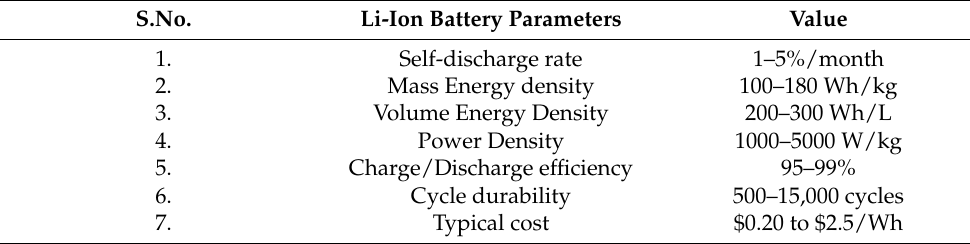
Table 1. Lithium-ion battery